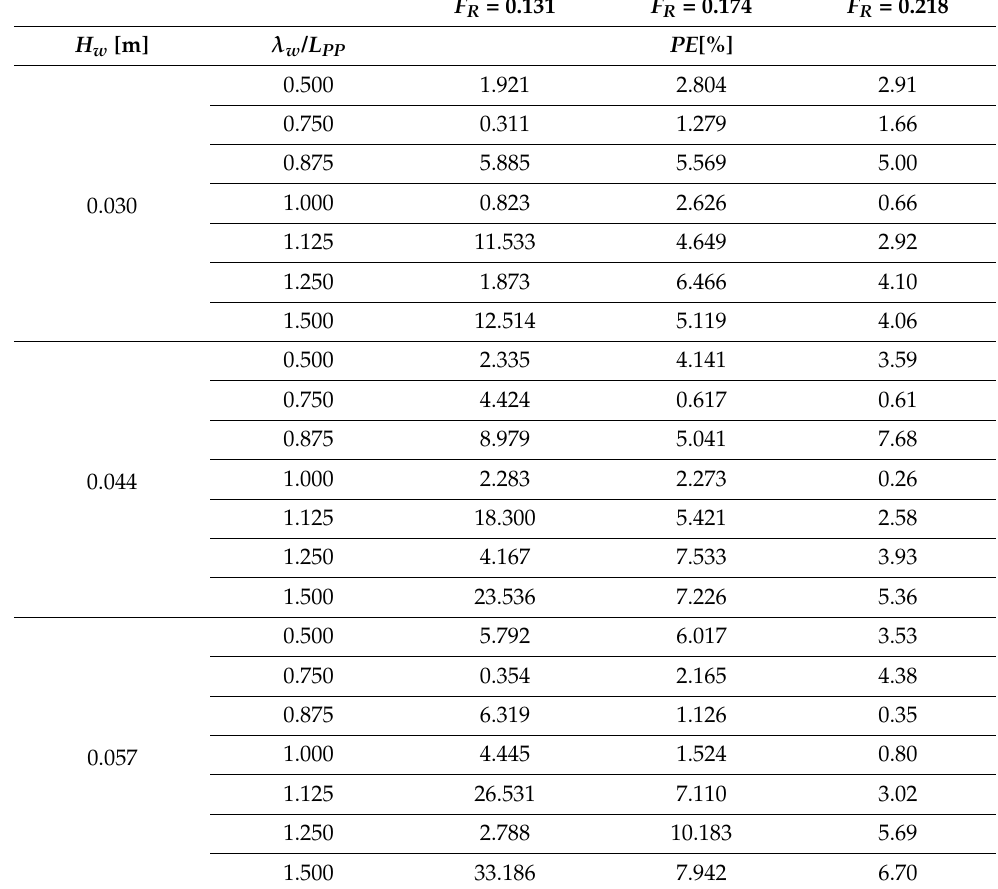
Table 5. Percentage error.